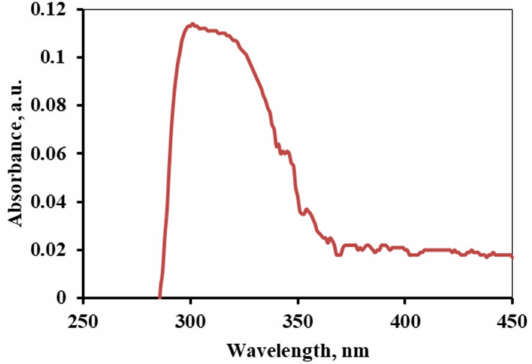
Figure 1. UV-Vis spectrum of an alkaloid of Acacia catechu